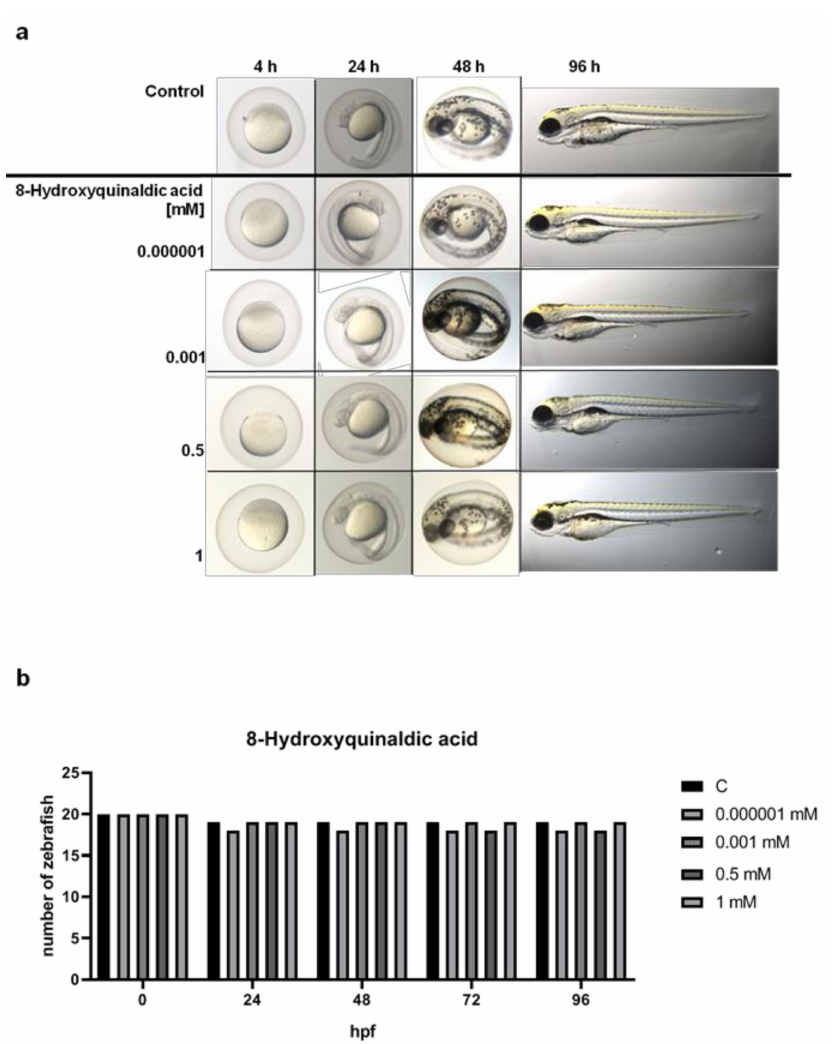
Figure 2. The e ff ect of 8-hydroxyquinaldic acid on development ( a ) and viability ( b ) of zebrafish larvae. Fertilized zebrafish (AB line) eggs ( n = 20) were exposed to E3 medium (control, C) or serial dilutions of 8-hydroxyquinaldic acid (0.000001; 0.001; 0.5, 1 mM) in E3 medium for 96 h. The medium was changed every 24 h. The microscopic observations were made in selected time points, i.e., 4, 24, 48, 72, 96